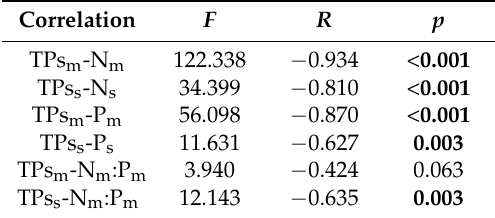
Table 3. Correlations between total phenolics (TPs) and nutrient concentrations (N and P), and N:P ratios of A. corniculatum leaves. Correlation Correlation